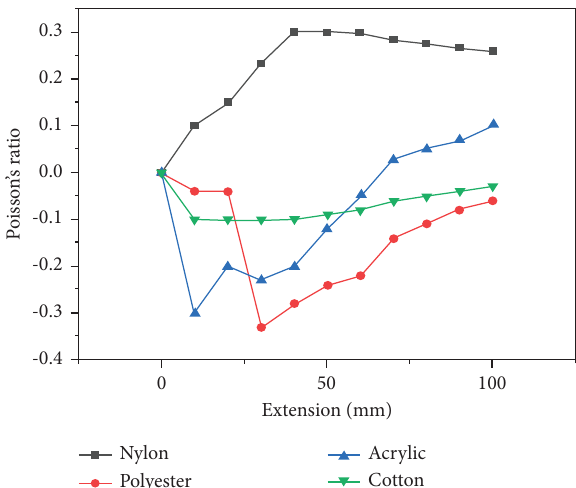
Figure 16: Negative Poisson’s ratio of star structures.